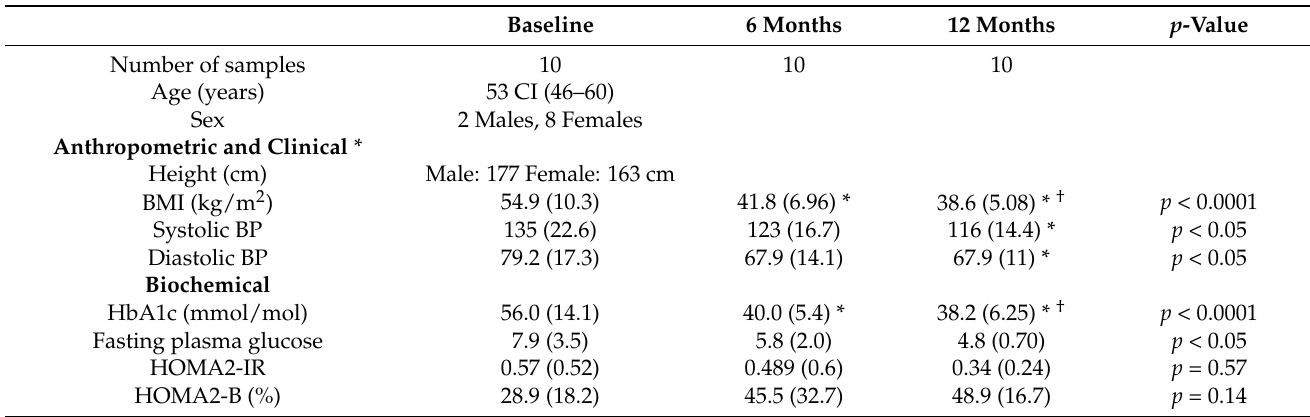
Table 1. Anthropometric and clinical measurements taken from patients before and after bariatric